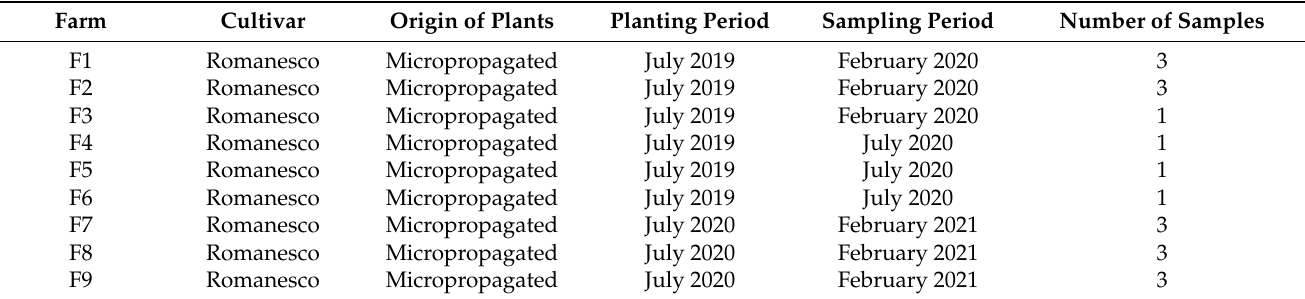
Table 1. Details of surveyed farms and number of plants collected for Phytophthora